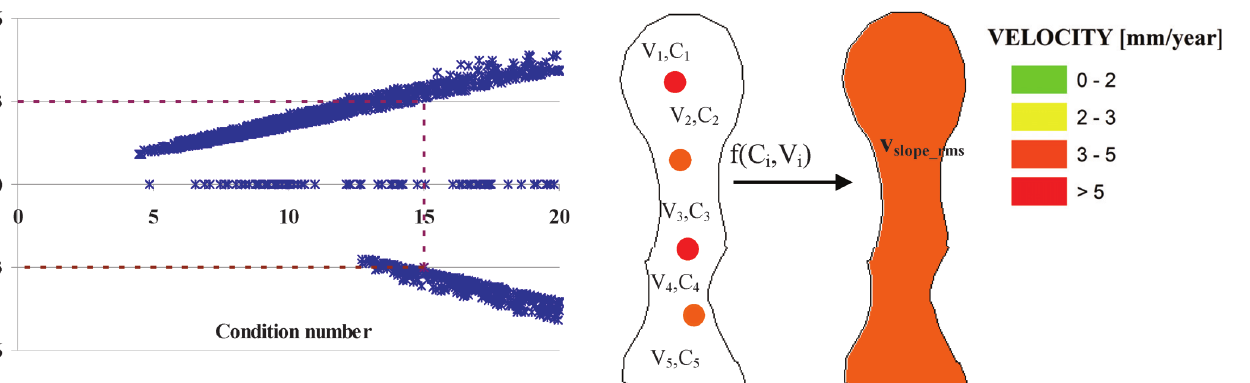
Fig. 8. The condition number vs. the scaling factor of the PS veloc- ity modulus relevant to the ENVISAT ascending dataset (Novem- ber 2002–July 2010). Fig. 9. Example of the landslide velocity computation as a function of both the along-slope velocity ( V slope ) and the coherence of the PS included in the boundary of the